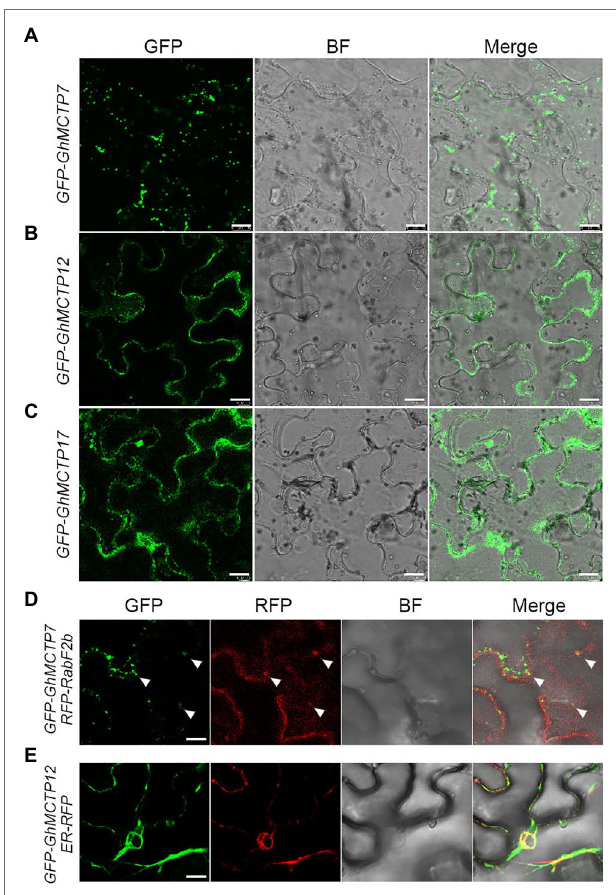
FIGURE 6 | Subcellular localization of green fluorescent protein (GFP)-GhMCTP7/12/17 in Nicotiana benthamiana leaf epidermal cells. (A–C) Representative GFP fluorescence images of GFP-GhMCTP7 (A) , GFP-GhMCTP12 (B) , and GFP-GhMCTP17 (C) . Scale bars = 50 μ m. (D) Colocalization of GFP-GhMCTP7 with an endosome marker (RFP-RabF2b). (E) Co-expression of GFP-GhMCTP12 with an ER marker (ER-RFP). Scale bars = 10 μ